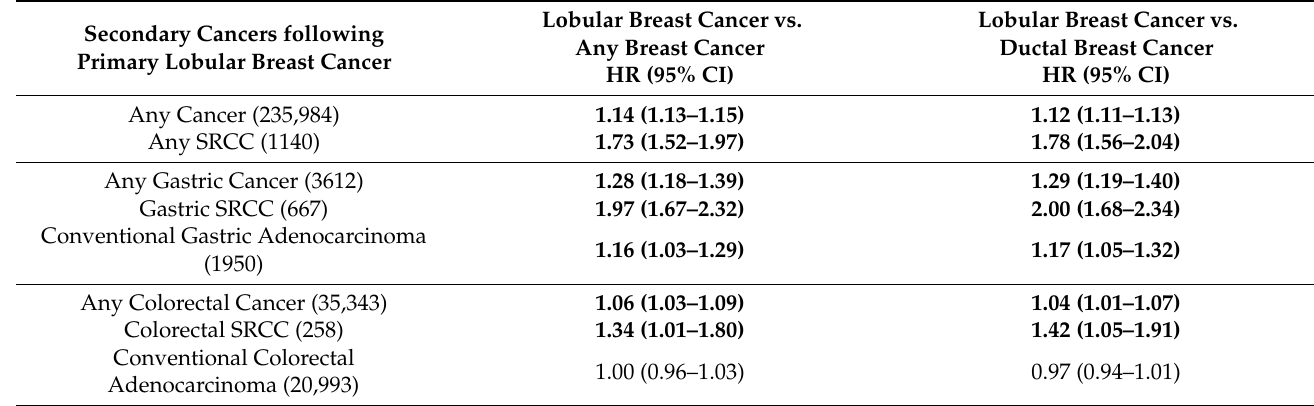
Table 7. Estimated hazard risk ratios (HR) with 95% confidence intervals (CI) for secondary cancers among patients with a primary sporadic lobular breast cancer compared to other patients with any other breast cancer type and ductal breast cancer in